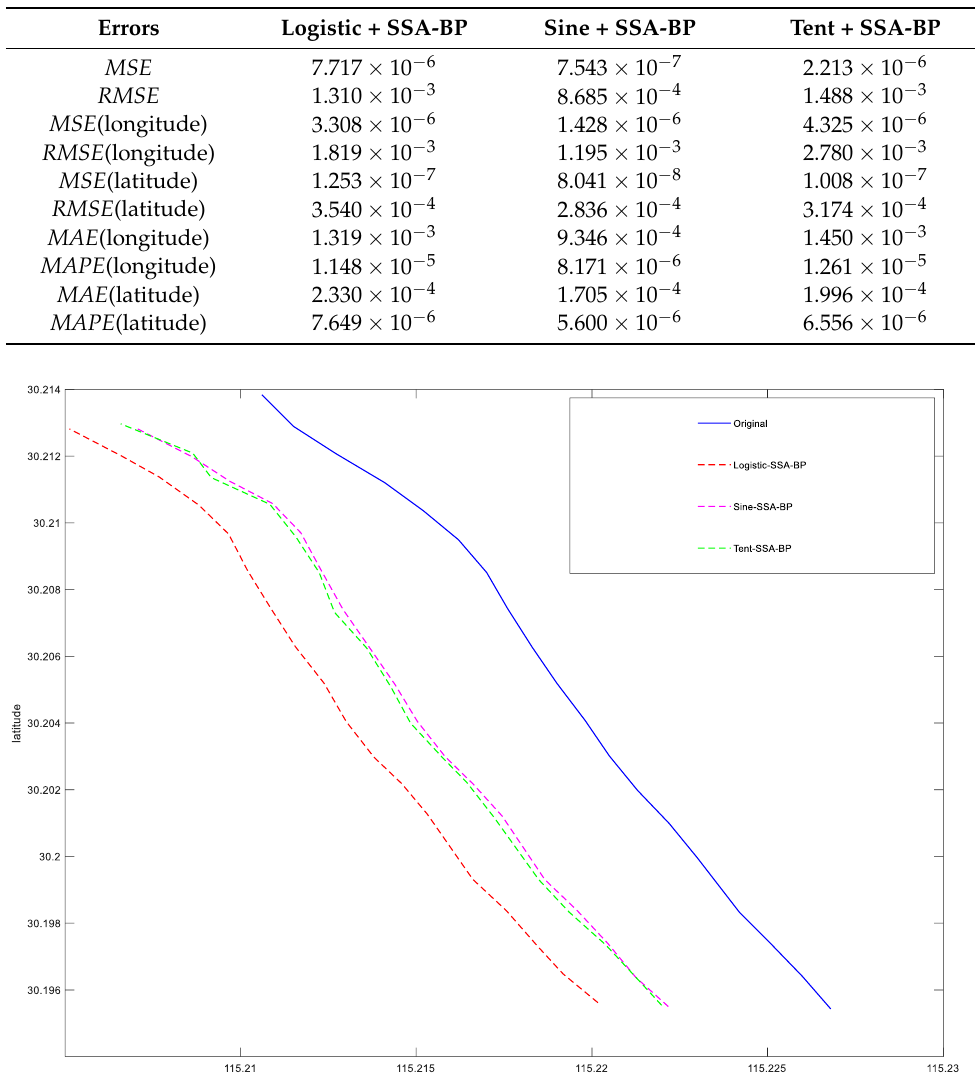
Figure 9. Comparison of trajectory prediction of three different structural models.